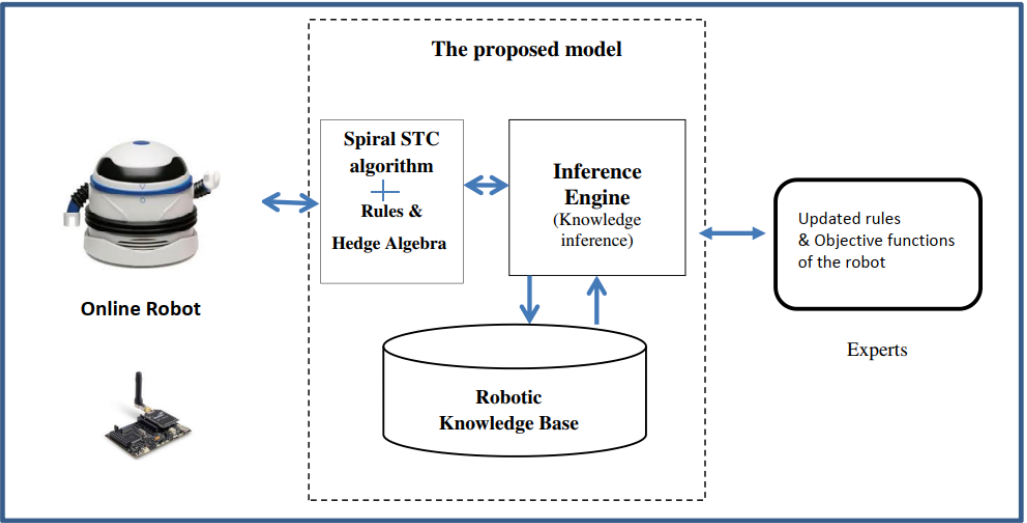
Figure 2. The proposed coverage path planning model for on-line robot